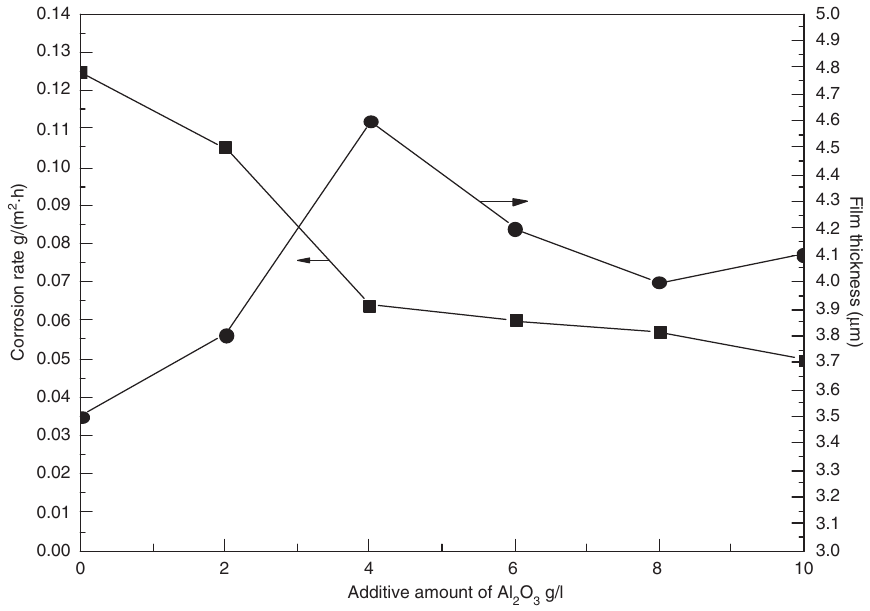
O on film thickness and corrosion 2 3